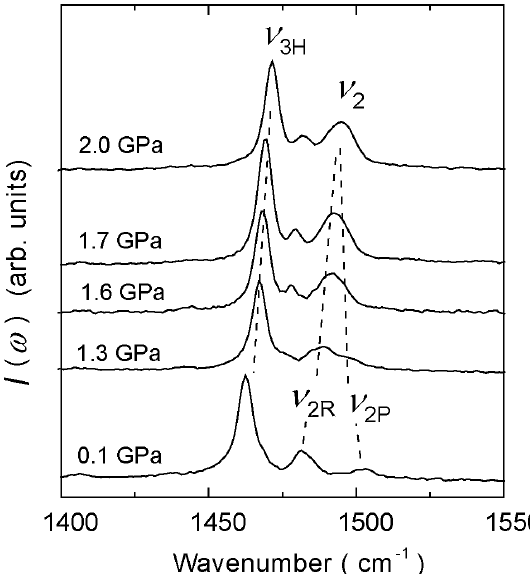
at 10 K. The broken lines are a guide for the